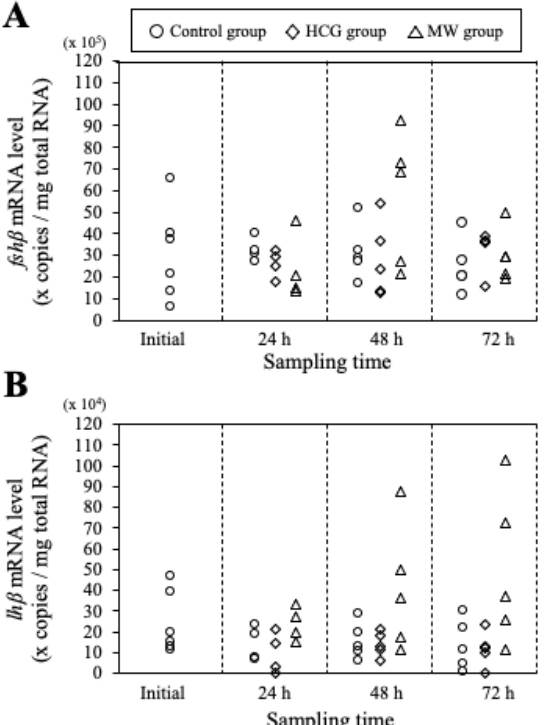
Figure 6. mRNA levels of GtH β -subunits, fsh β ( A ) and lh β ( B ), in the pituitary. Y-axis shows the mRNA concentration normalized by total RNA. X-axis shows sampling time after the start of the experiment. The symbols indicate the experimental groups as follows: ○ , control group; ◇ , human chorionic gonadotropin (HCG)-treated group; △ , male water (MW)-treated group.